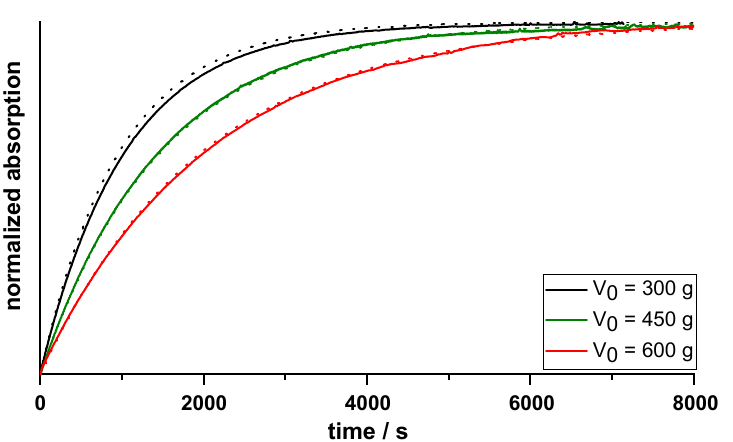
Figure 5. Normalized absorption curves during continuous addition of tracer solution (0.1 mL/min, solid lines) vs. predicted curves (dotted lines), at constant 𝑉(cid:4662) (cid:2925)(cid:2931)(cid:2930) = 23.80 mL/min, and three different fill levels (n = 1).